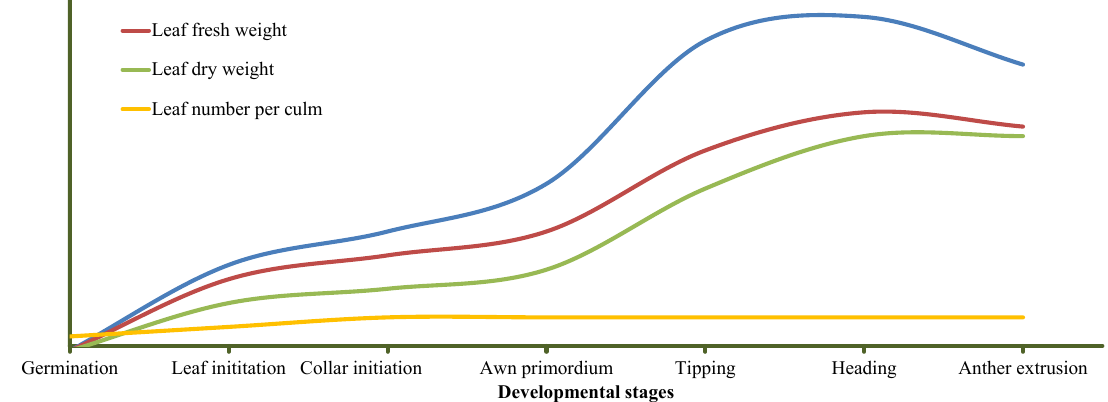
Figure 5. General trend of leaf traits in barley at developmental stages. Data was collected from nine biological replicates of 32 barley accessions ( n = 32 accession × 3 replicates × 3 growth